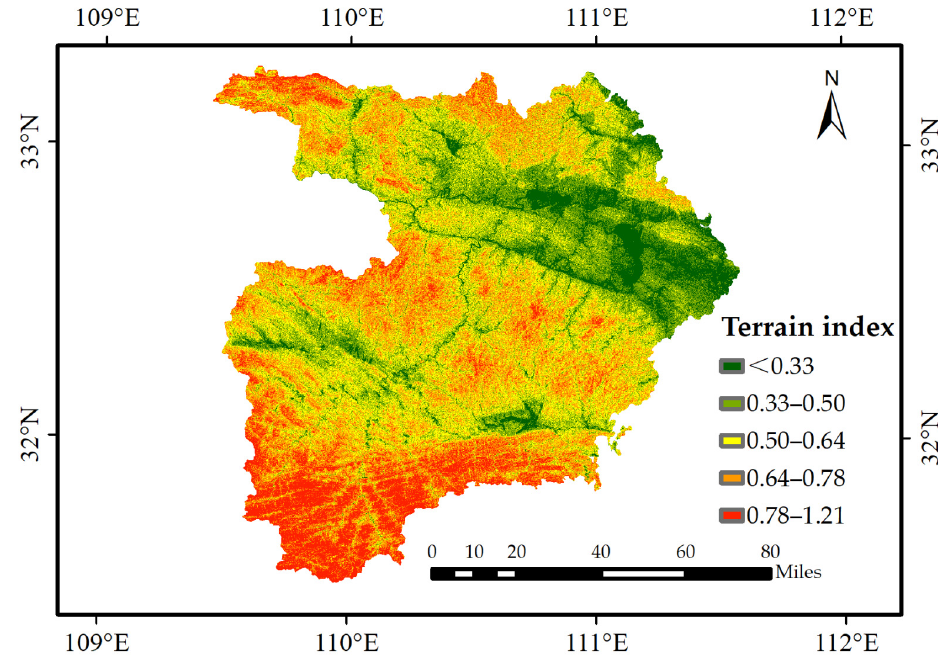
Figure 9. Spatial distribution of terrain index values in Shiyan.